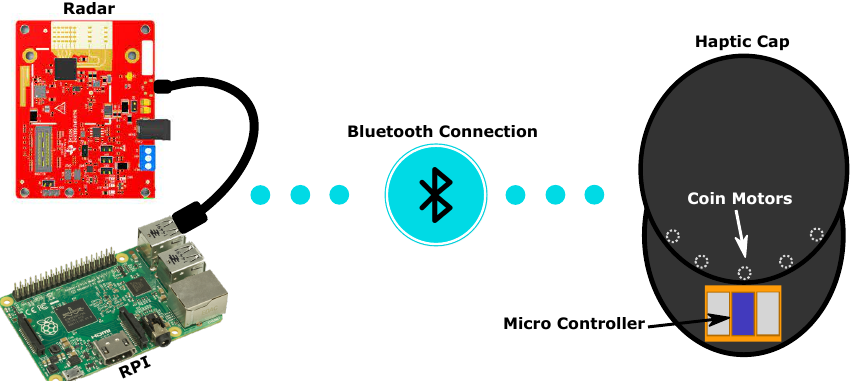
Figure 1. Schematics of the proposed system. The radar transceiver is connected to a Raspberry Pi via USB and sends data about the scene via low energy Bluetooth to the micro-controller on the baseball cap. The micro controller sends pulses to the corresponding coin